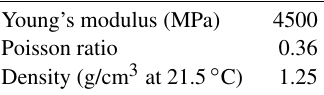
Table 2. Mechanical properties of the PLA